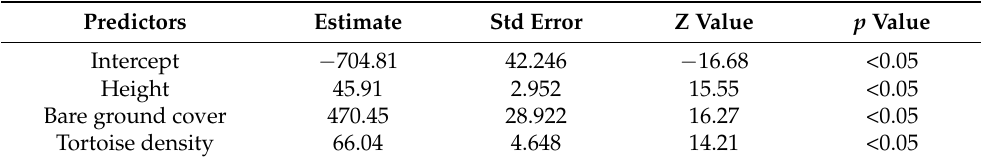
Figure 2. Location of trees with nests of Common raven Corvus corax within the study area by breeding season ( n = 4, n = 19 and n = 18 in 2018, 2019 and 2020, respectively). A distinction is made between trees used for nesting in only one season (in yellow for 2018, dark green for 2019 and light green for 2020, respectively), those used in more than one season (in red those occupied in 2019 and 2020 and in orange those used in 2018, 2019 and 2020) and randomly selected trees without nests (in black, random tree). Table 1. Characteristics of trees with and without (random tree) Common raven Corvus corax nests: height (H) and diameter at breast height (DBH), density of mature trees (>30 cm DBH within a radius of 15 m), scrub and bare ground cover in 200 m radius, nearest road distance and nearest Table 2. Statistical parameters of the generalized linear mixed model used to explain raven nest-site selection. See electronic Supplementary Materials Table S1 for model